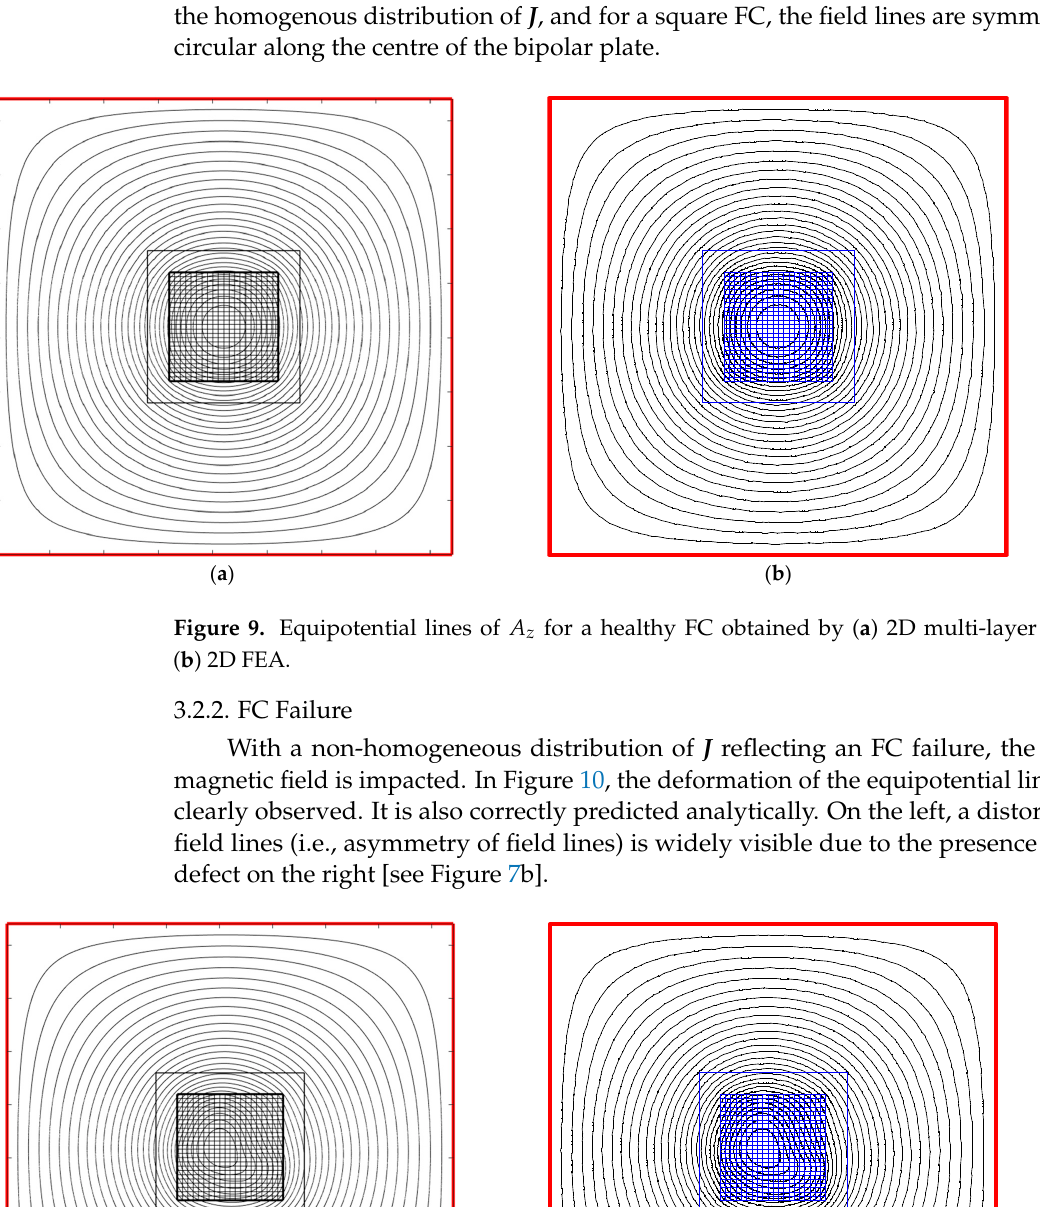
Figure 10. Equipotential lines of z A for an FC failure obtained by ( a ) 2D multi-layer model and ( b ) 2D FEA.